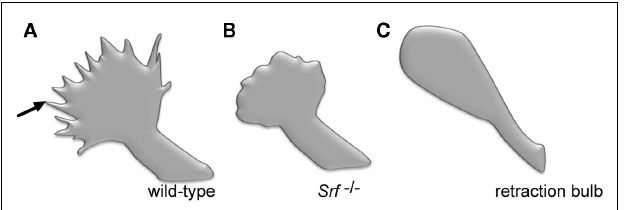
FIGURE 1 | Comparison of SRF-deficient growth cones with retraction bulb. (A) Scheme of a growth cone of a wild-type neuron grown in cell culture.The growth cone typically protrudes multiple finger-like filopodia (one is marked by an arrow). (B) A growth cone derived from an SRF-deficient neuron grown in culture. Please note the reduced number of filopodia resulting in a round shape of the growth cone. (C) A